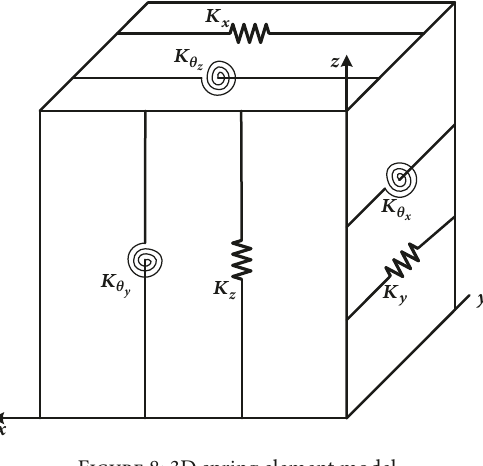
Figure 8: 3D spring element model.